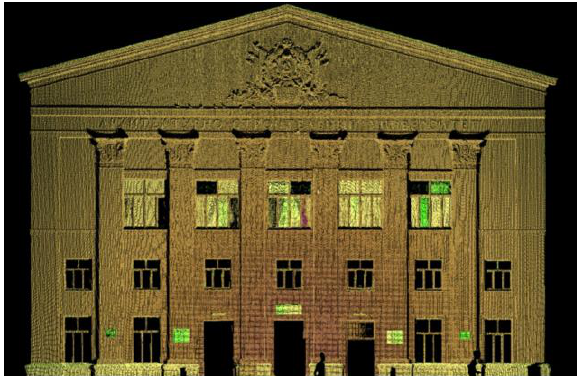
Figure 4. The three-dimensional façade model from TLS point clouds Three-dimensional façade models from TLS point clouds shown in Fig. 2 and 4 are represented in accordance with the intensity of reflected